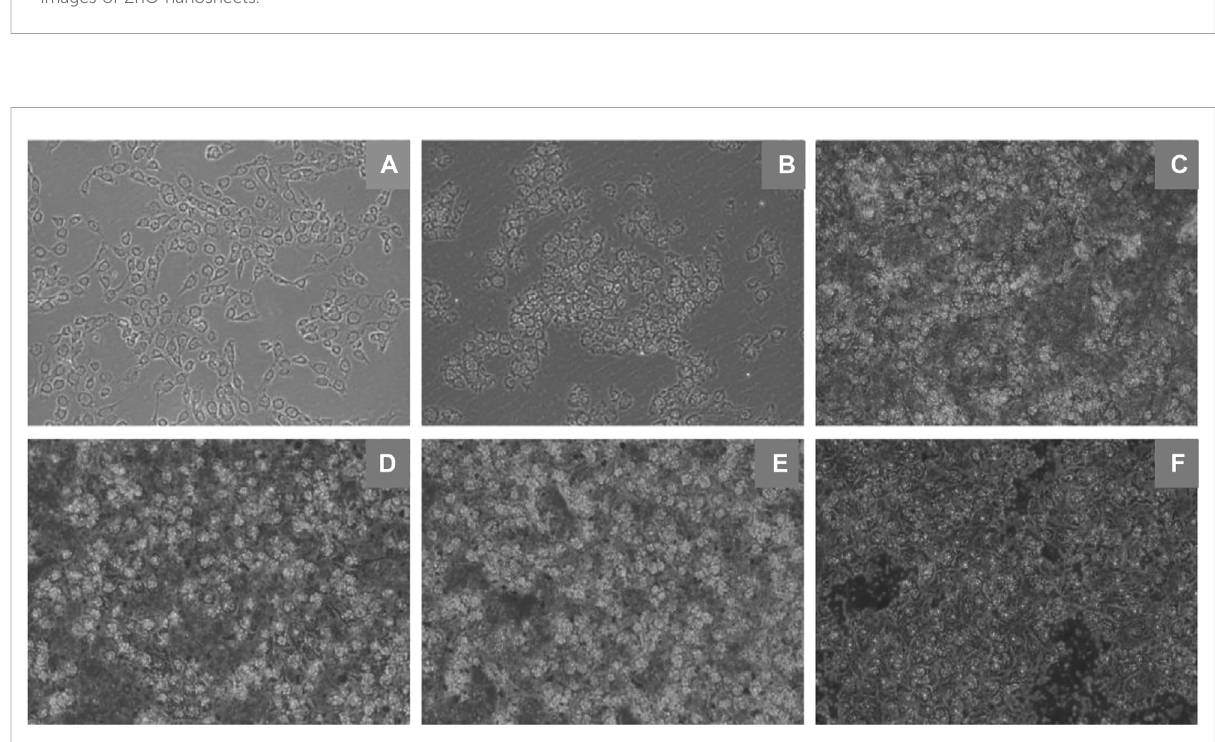
FIGURE 2 TEM, HRTEM, and SEM images of ZnO nanomaterials. (A) TEM images of ZnO nanosheets; (B) HRTEM images of ZnO nanosheets; and (C) SEM images of ZnO